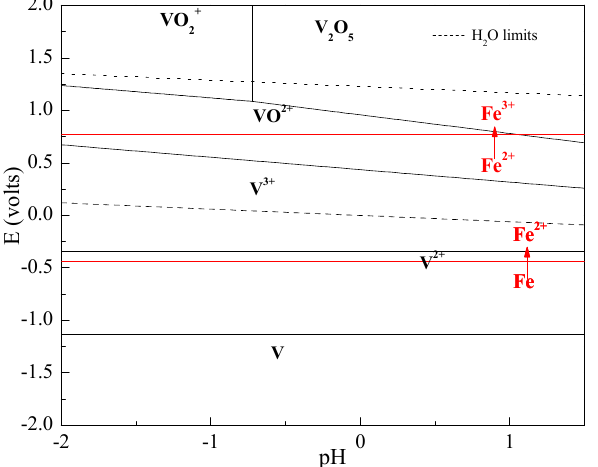
Figure 1. E -pH diagram of the system V-H 2 O at 298.15 K (activity of vanadium is 1.0).